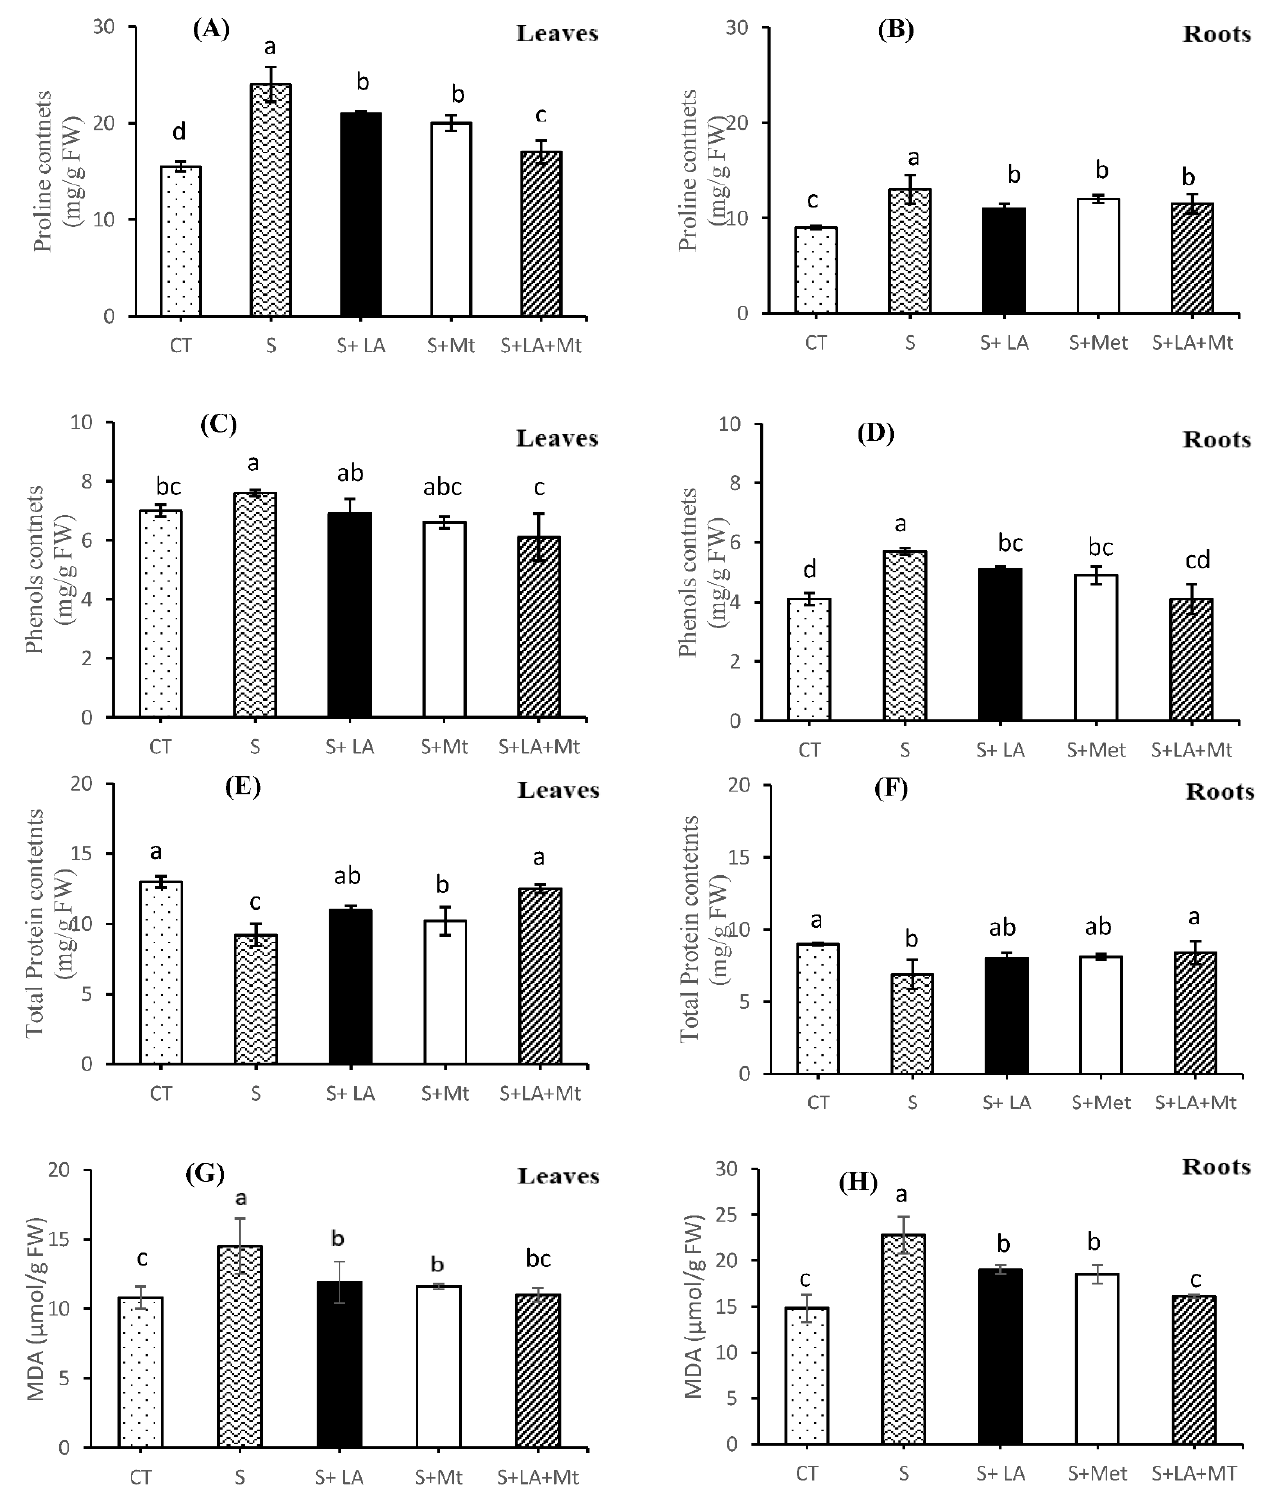
Figure 6. The effect of lipoic acid (LA), melatonin (MT) and their combination (LA + MT) under salt stress on proline contents in leaves ( A ) and roots ( B ), total phenol contents in leaves ( C ) and roots ( D ), total protein contents in leaves ( E ) and roots ( F ) and malondialdehyde (MDA) contents in leaves ( G ) and roots ( H ) of Brassica napus L. seedlings exposed to salinity (100 mM NaCl) for 30 days. Abbreviations are given in the Figure 1. Error bars on each column show the ± SE of three replication samples. Different letters on each bar indicate a significant difference according to LSD test ( p ≤ 0.05).